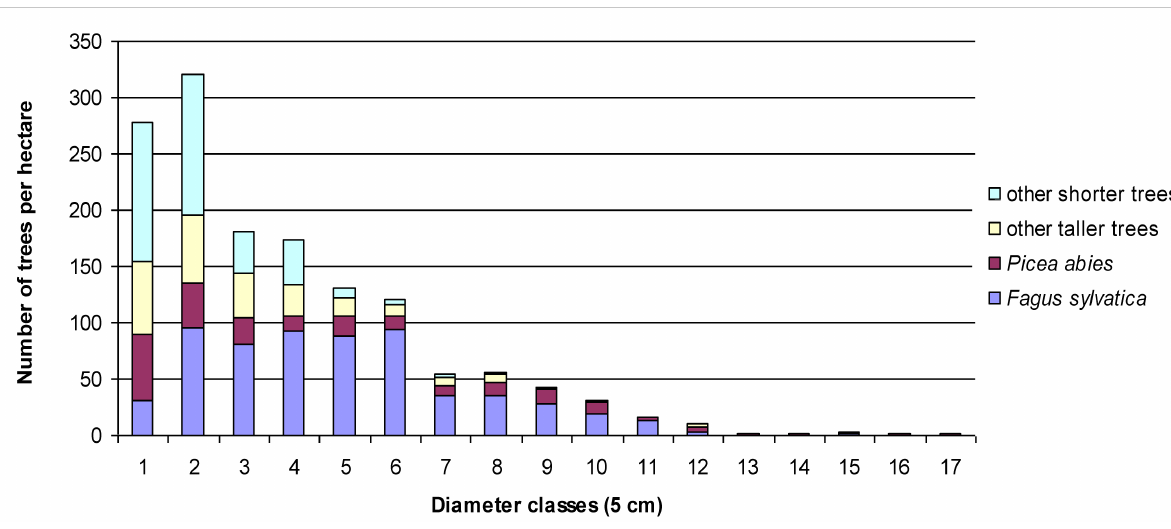
Figure 1. Frequency distribution of trees per diameter at breast height (DBH) class